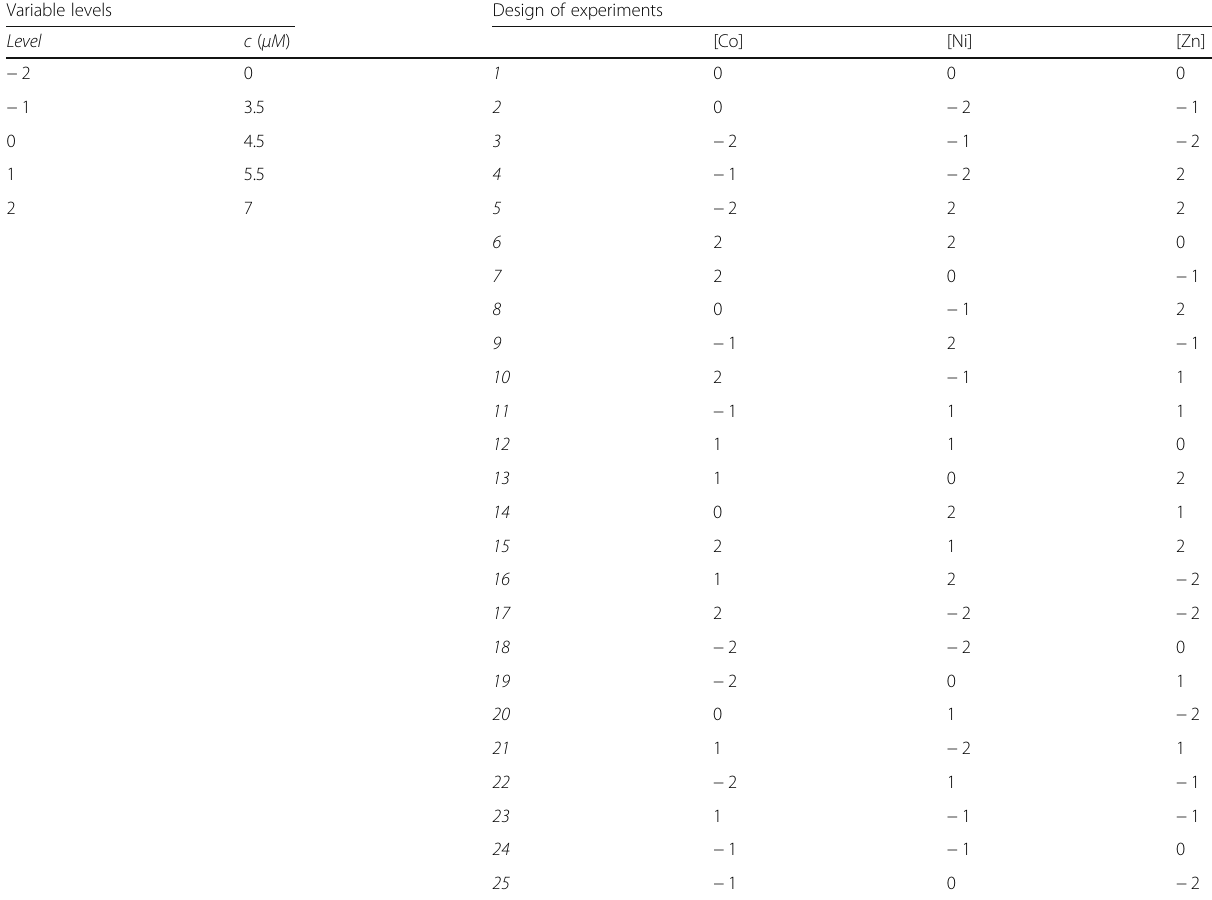
Table 4 MPFD experimental design: 5 levels for 3 components. V = 25 mL of ammonia buffer solution at pH = 10 and 0.033 g of PAN-CC Variable levels Design of